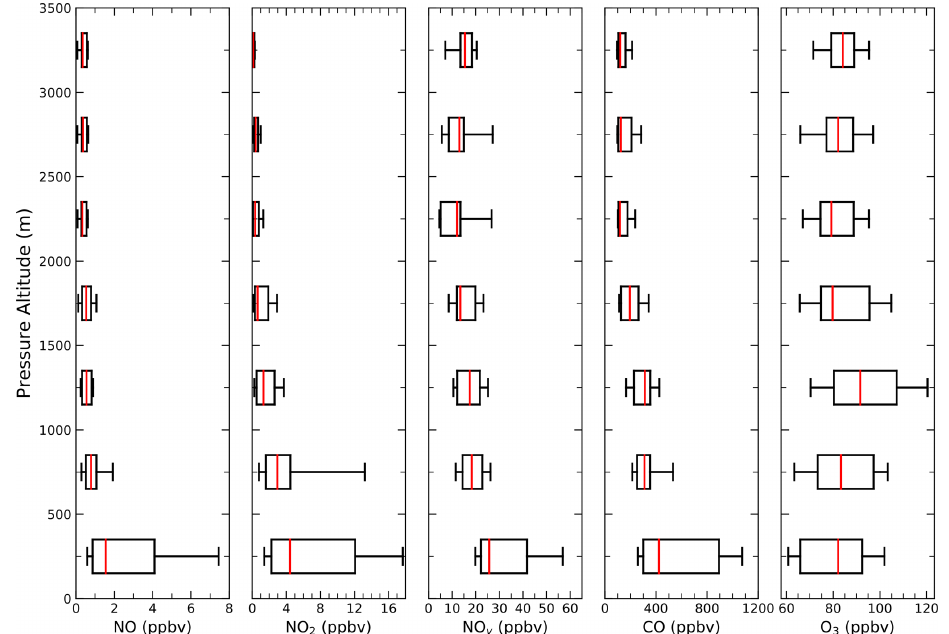
Figure 2. Box and whisker plots of 1s profiles of NO, NO 2 , NO y , CO, and O 3 for data collected in 500m bins. The whiskers show the 10th and 90th percentiles, the box denotes the 25th and 75th percentiles, and the central red line indicates the median value within each bin. Average PBL height for all ARIAs flight is ∼ 1500m. The total number of observations at altitudes above 2500m of NO and NO y is small ( ∼ 2200 or about ∼ 30min of measurements) since the NO / NO y instrument cannot measure both species simultaneously.